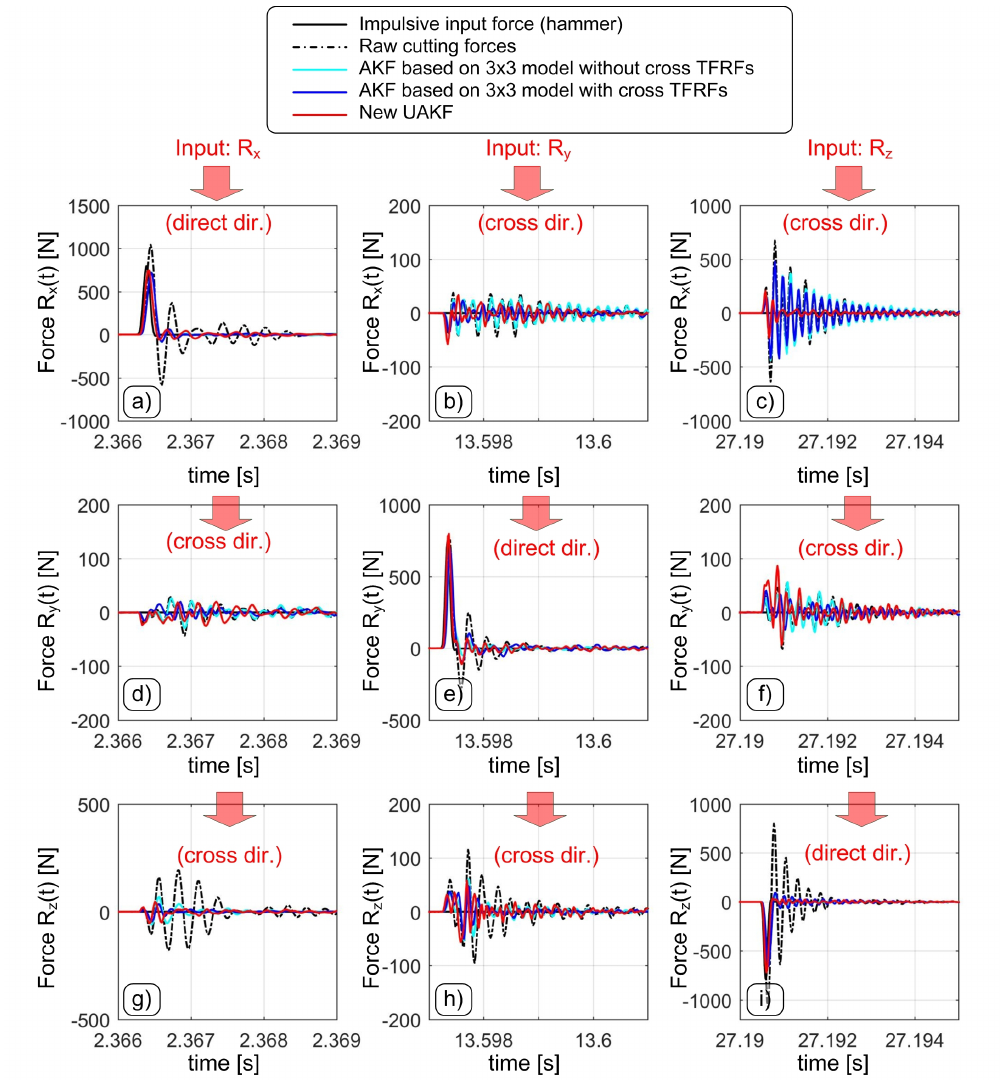
Figure 4. Example of generic impulse transients before and after the correction by using the developed Kalman filter. The filtered transients along the R x , R y and R z directions when hitting the device along the R x direction are showed in ( a ), ( d ) and ( g ) respectively. Similarly, the filtered transients when hitting the device along the R y direction are showed in ( b ), ( e ) and ( h ) respectively. Eventually, the filtered transients when hitting the device along the R z direction are showed in ( c ), ( f ) and ( i )